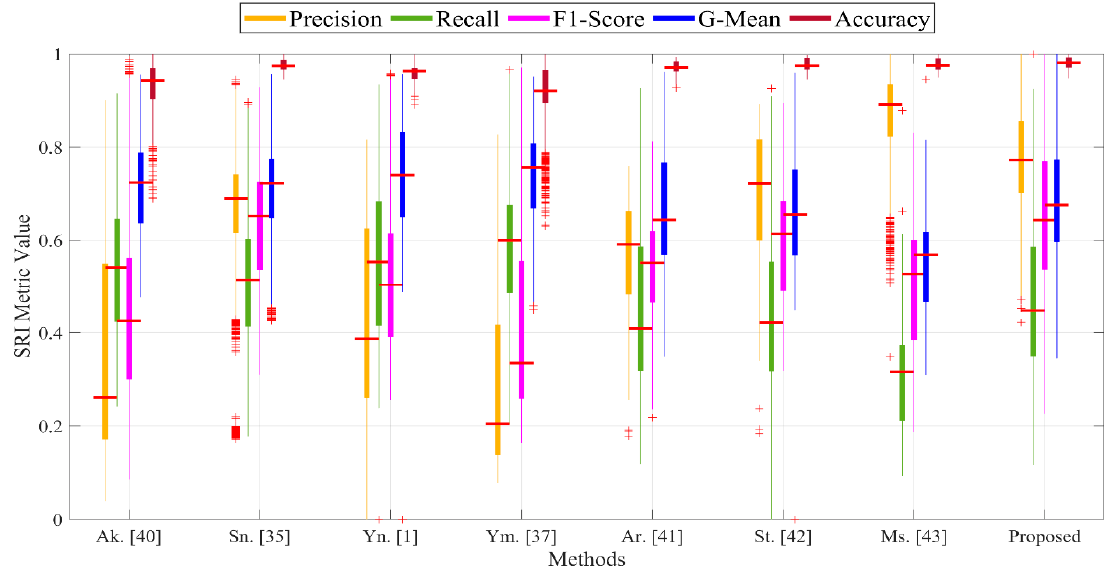
Figure 12. Evaluation results for SRD performances of different methods for 121 sub-aperture + 1 maximum images × 18 objects = 2196 images with specular reflections in terms of precision, recall, F1-score, G-mean, and accuracy.